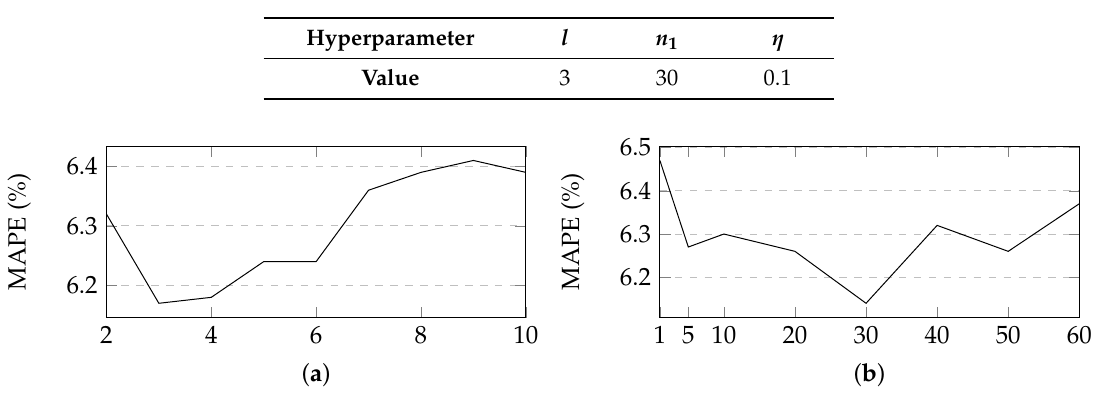
Table 3. Hyper parameters value used in our experiments.